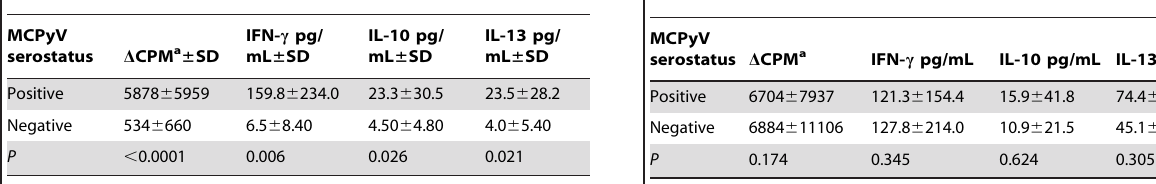
Table 1. Comparison of MCPyV-specific proliferation and cytokine responses among 15 MCPyV seropositive and 2 15 seronegative subjects at 0.25 m g/ml antigen concentration.